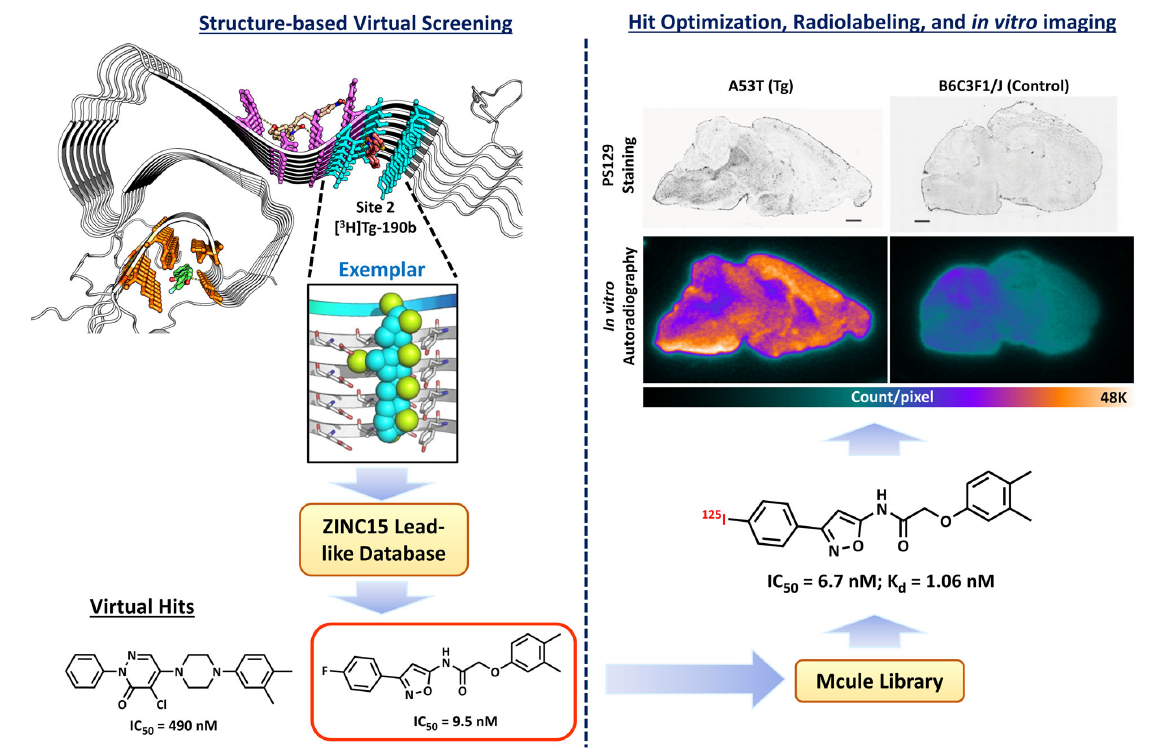
Figure 3. A summary workflow from Ferrie et al. that identified lead compounds from structural- based VS.